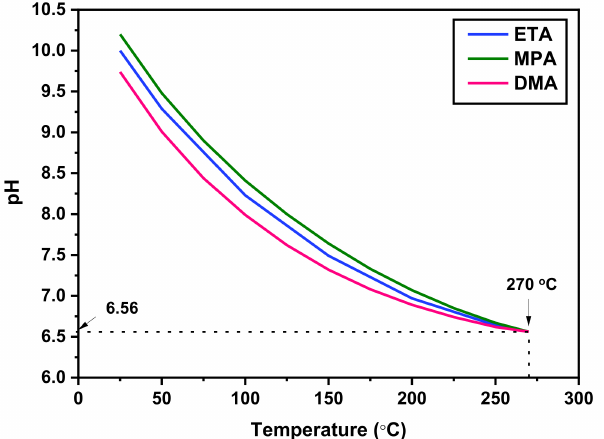
Figure 1. Calculated pH of ETA, MPA, and DMA solutions as a function of temperature using the MULTEQ